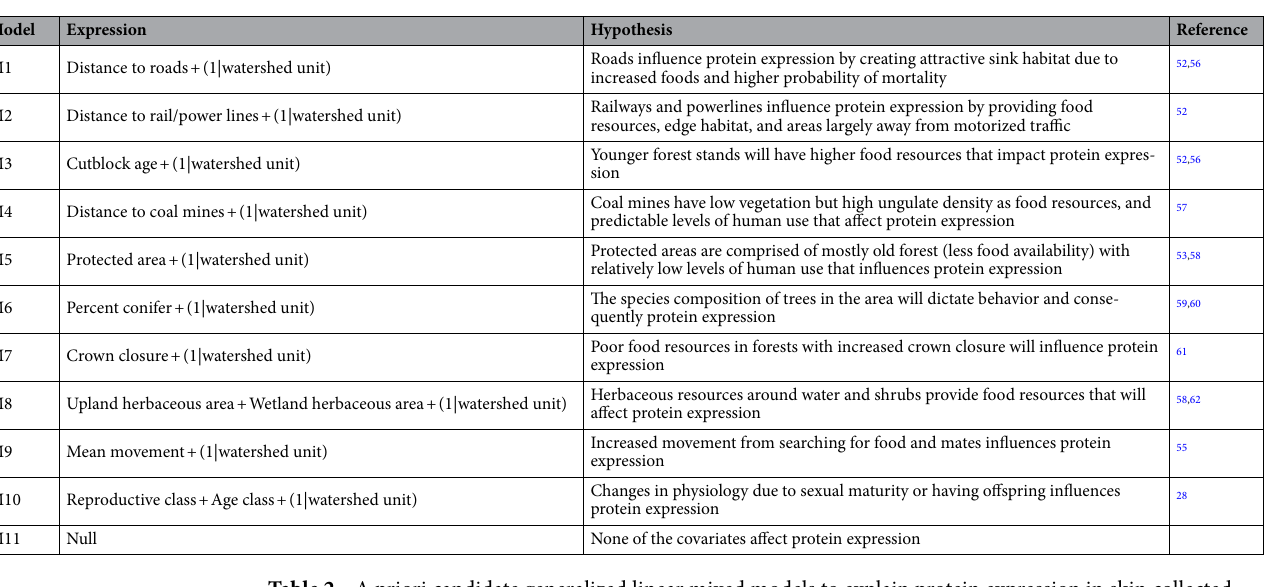
Table 2. A priori candidate generalized linear mixed models to explain protein expression in skin collected from grizzly bears in Alberta,